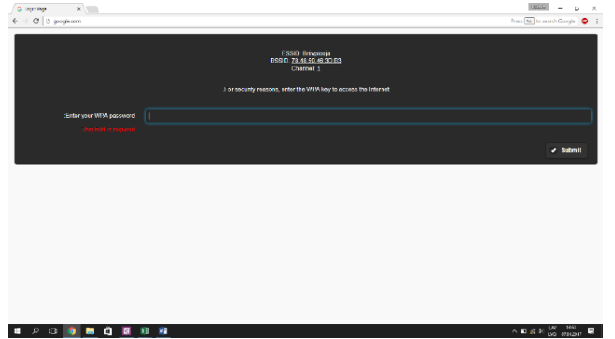
Fig. 7. Screenshot of the phishing website used in the social engineering attack.